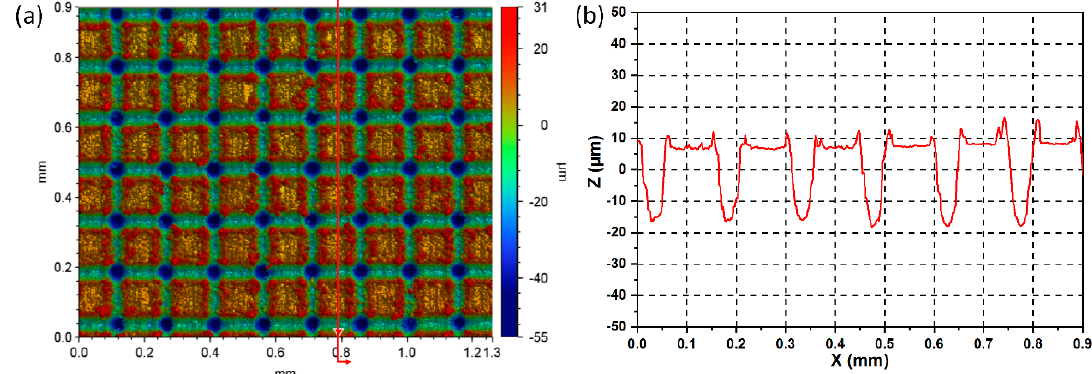
Figure 2. ( a ) 3D and ( b ) cross-sectional profilers of the super-hydrophobic surface.